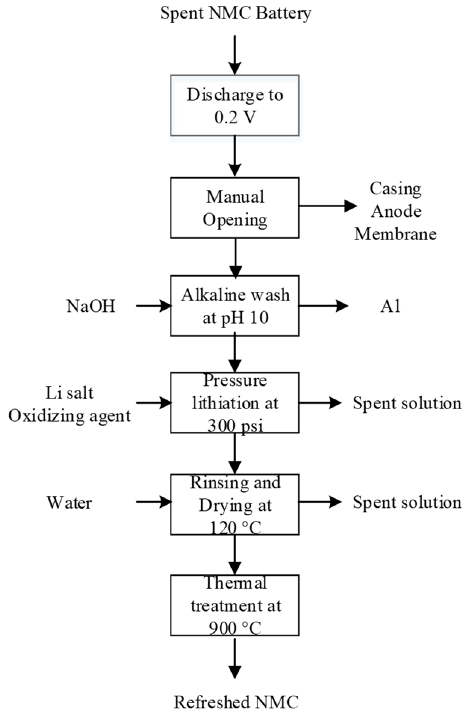
Figure 18. Hydrothermal process proposed by Sloop (according to [218]).